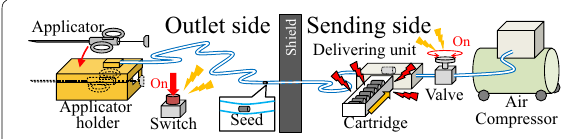
Fig. 4 Concept of the remote radioactive seed-loading device